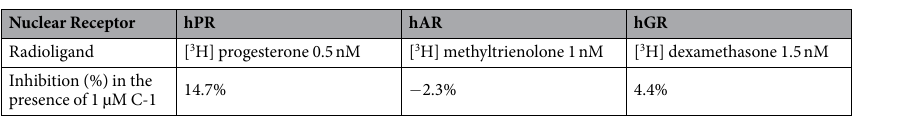
Table 2. Very low affinity of C-1 for other nuclear receptors. The binding inhibition rate (%) of compound C-1 for PR, AR, and GR was determined. Each recombinant human nuclear receptor was incubated with the indicated concentration of the radiolabeled ligand and 1 µ M C-1 for 6–20 hr at 4 °C. Inhibitory effects of C-1 were determined by scintillation counting. These results show very low affinities of C-1 for other nuclear receptors. Abbreviation : AR , androgen receptor; GR , glucocorticoid receptor; PR , progesterone